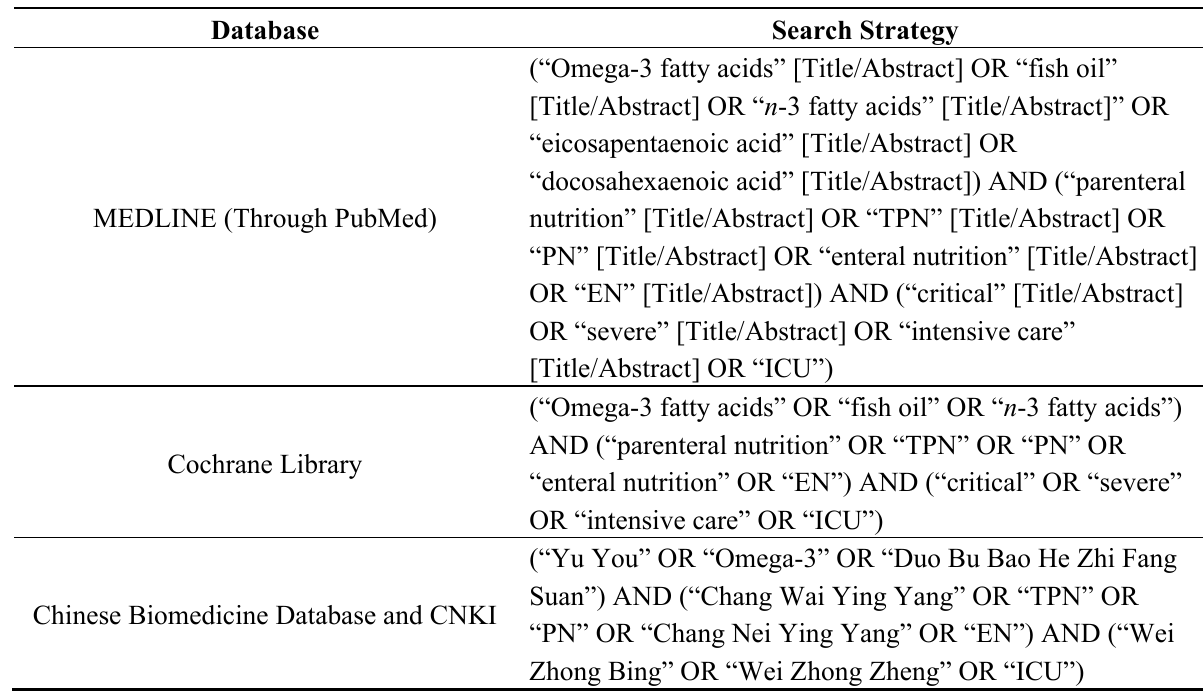
Table 1. Literature research strategy, databases and key